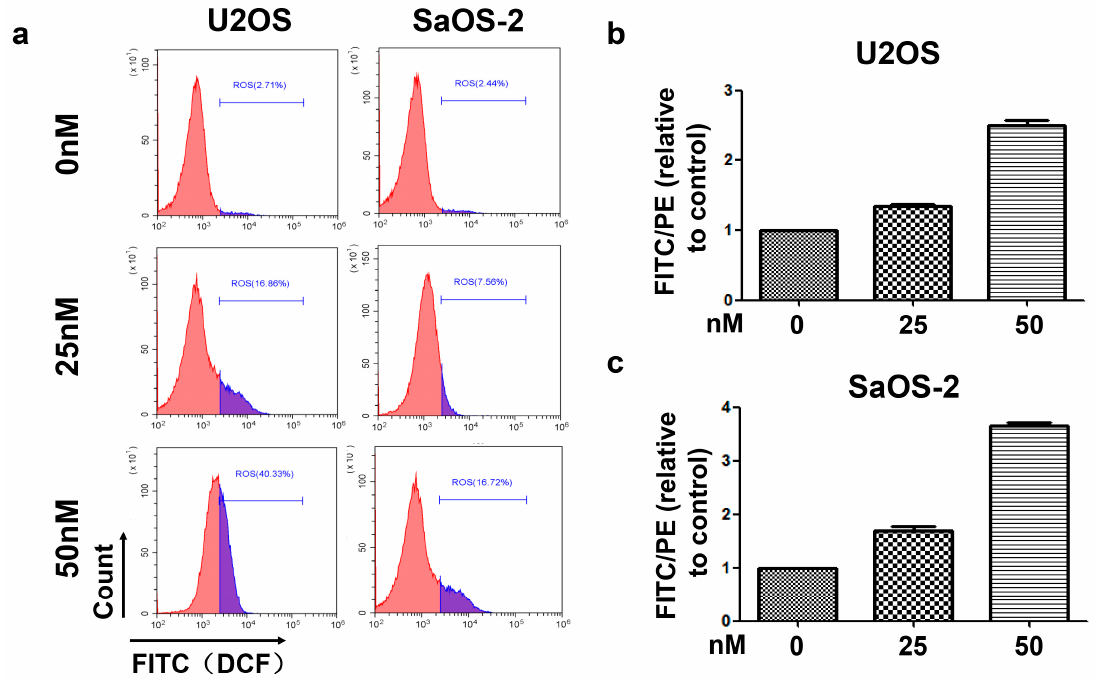
Figure 3. ( a ) Intracellular ROS level of U2OS and SaOS-2 cells treated with different concentrations of oleandrin that detected by FCM (purple region means the percentage of cells with positive DCF); ( b ) Semi-quantitative analysis of relative mitochondrial membrane potential (MMP) level (ratio of FITC/PE) in U2OS cells that detected by FCM, relative to the control (0 nM) group; n = 3, Mean ± SEM; and ( c ) Semi-quantitative analysis of relative MMP level (ratio of FITC/PE) in SaOS-2 cells detected by FCM, relative to the control (0 nM) group; n = 3, Mean ± SEM.